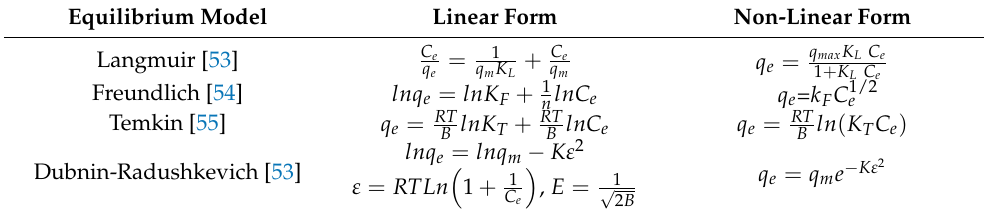
Table 3. Equilibrium models.